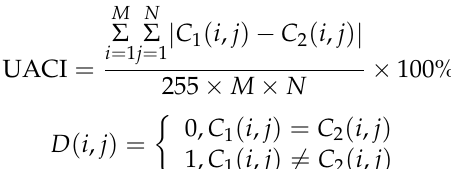
algorithm is not associated with the plain image. The generation of the chaotic initial